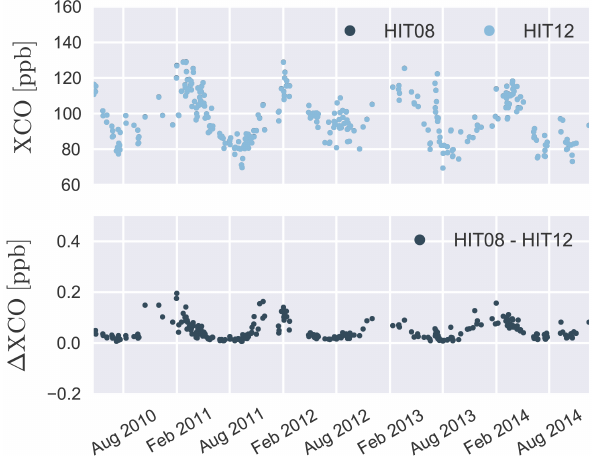
Figure 7. Upper panel: daily mean time series of XCO retrieved from MIR spectra following the NDACC retrieval methodology for the HITRAN 2008 (HIT08) and HITRAN 2012 (HIT12) spectro- scopic line lists; lower panel: the absolute difference time series shows the impact from the change of spectroscopic parameters.